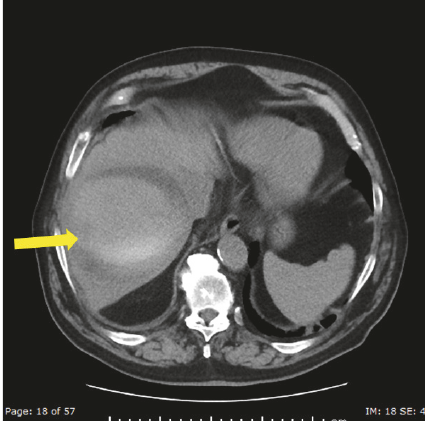
Figure 5: Axial plane CT of the abdomen without contrast done 1 week after the embolization demonstrates a large collection replacing most of the right hepatic lobe. There is central increased attenuation with layering (yellow arrow) consistent with retracting clot.